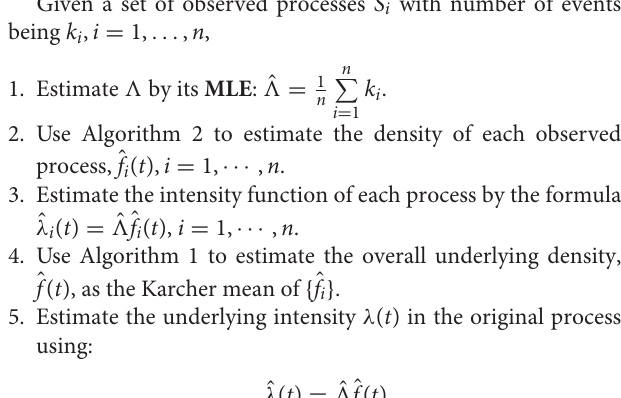
Algorithm 3: Intensity Estimation